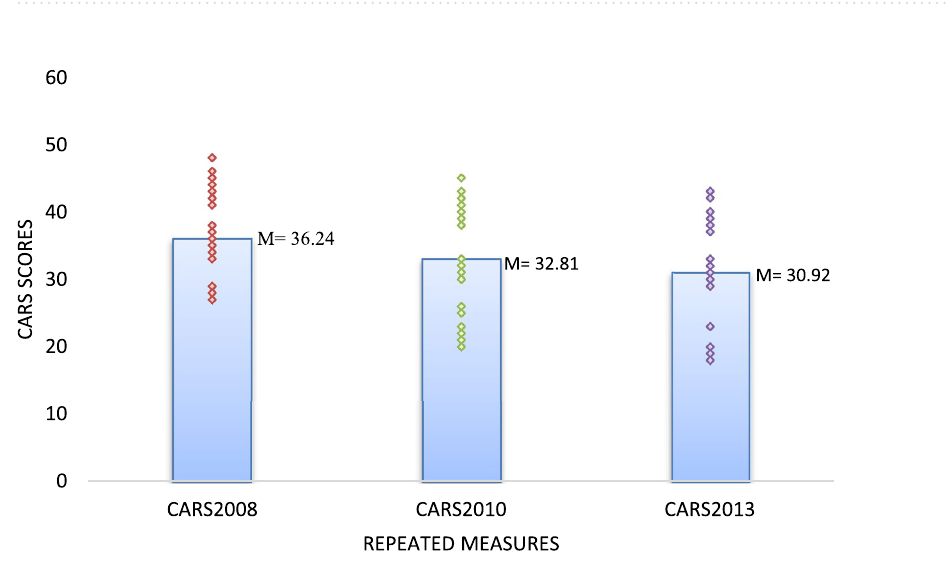
Figure 1. Mean Differences Between Pre-. Post-. and Follow-up Test on CARS (n =